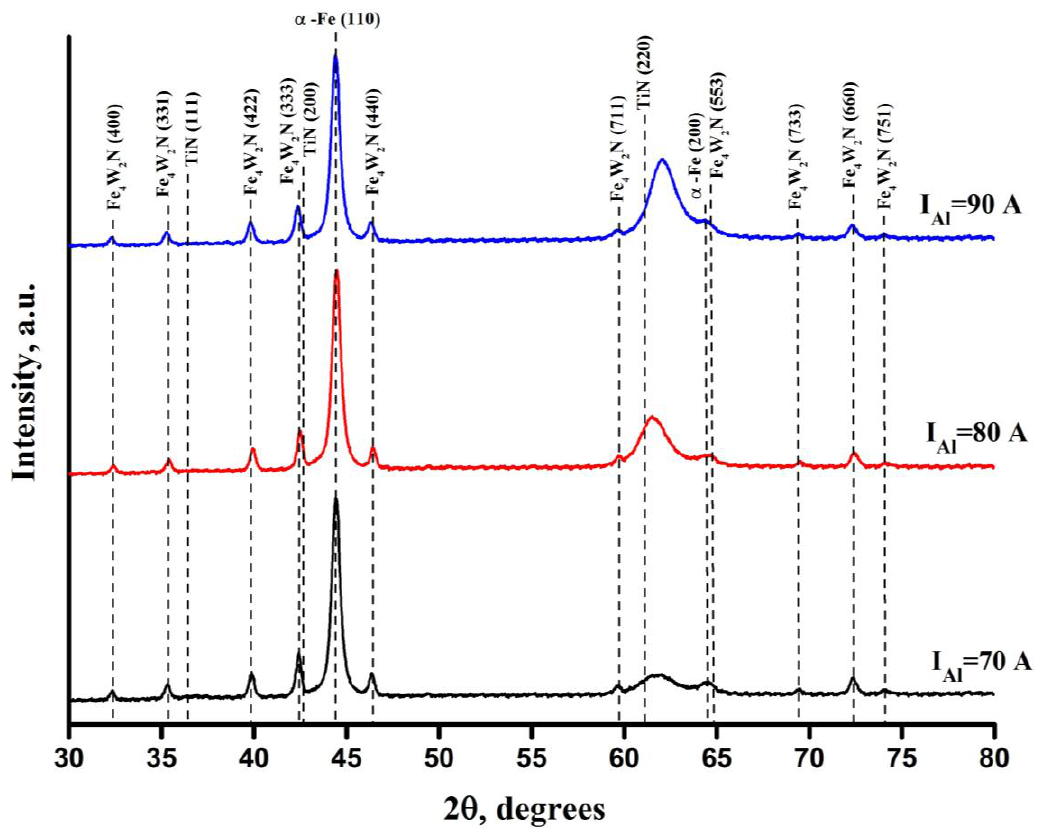
Figure 4. X-ray diffraction (XRD) analysis of Ti-Al-N coatings.